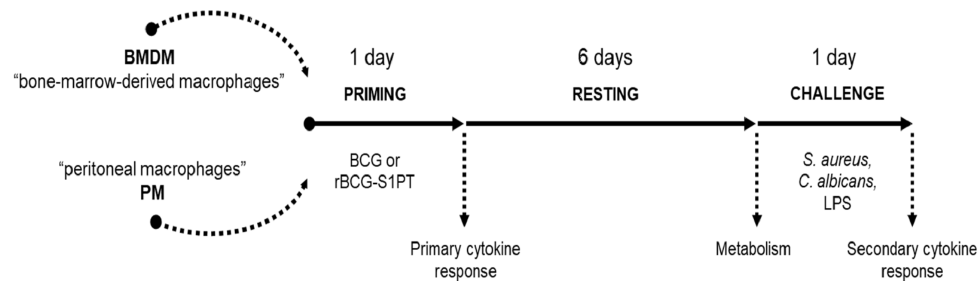
Figure 1. Schematic representation of the experimental approach using BMDM and PM. C57BL/6 mice were euthanized, and femur, tibia, and peritoneal cells were collected. Bone marrow cells were differentiated to macrophages (BMDM). Peritoneal macrophages (PM) were purified by adherence. BMDM and PM were primed with BCG or rBCG-S1PT for 1 day, and the supernatants were collected to determine the primary cytokine response. The cells were then left to rest for 6 days. Before the addition of the secondary stimuli (challenge), the supernatant was collected to measure glucose and lactate levels (metabolism analysis). After 1 day of re-stimulation with S. aureus , C. albicans , or LPS, the supernatants were collected to determine the secondary cytokine